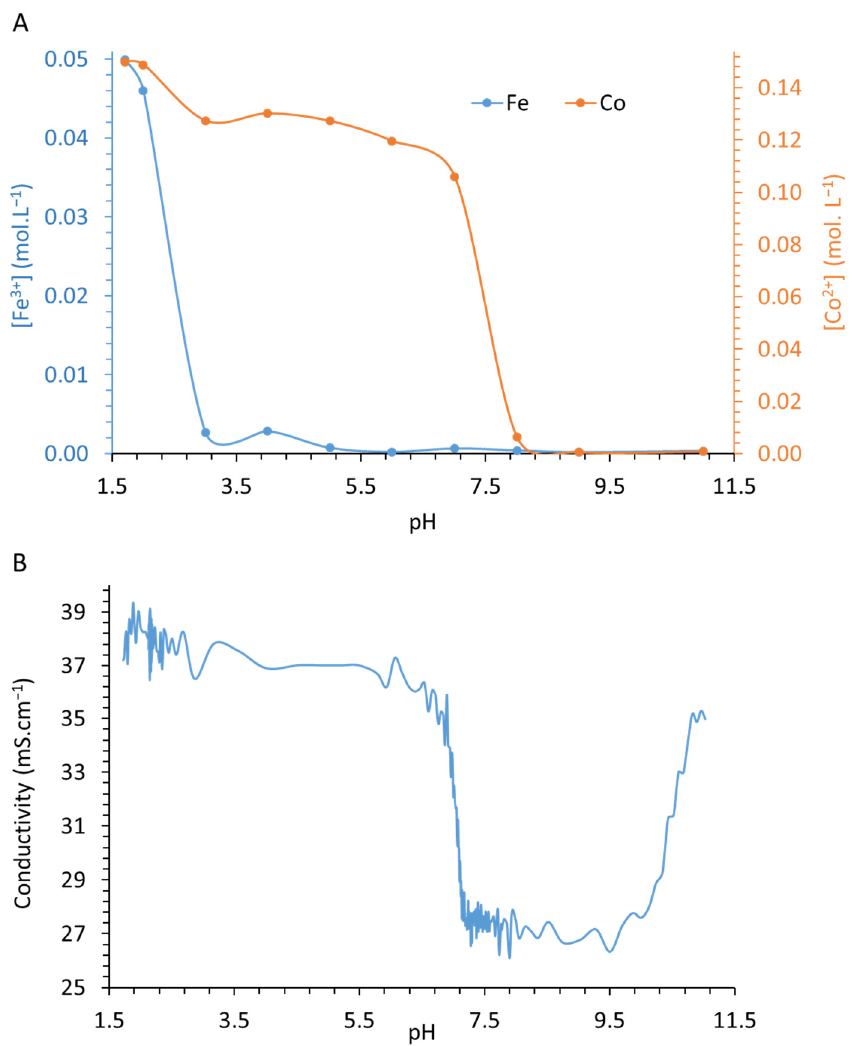
Figure 2. ( A ) Remaining concentrations of Fe (blue) and Co (orange) in the supernatant and ( B ) measured conductivity as a function of the corresponding titration pH. ( B ) measured conductivity as a function of the corresponding titration